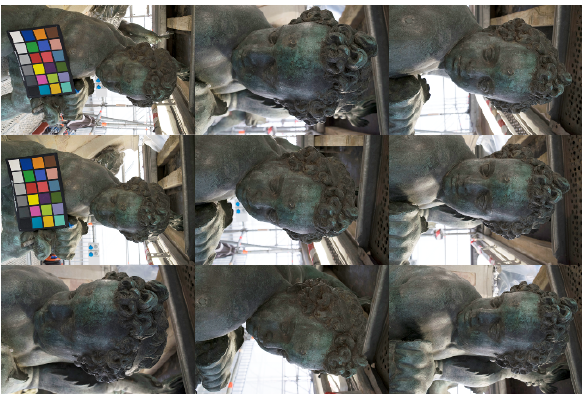
Figure 5. The female Putto datasets.